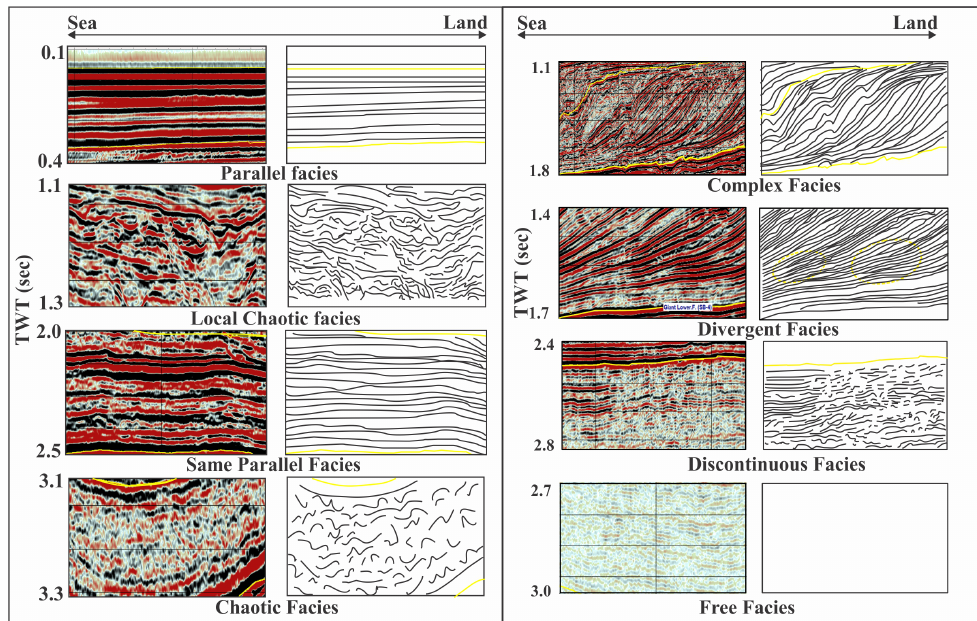
Figure 7. Layout of the dominant seismic facies were detected of the studied